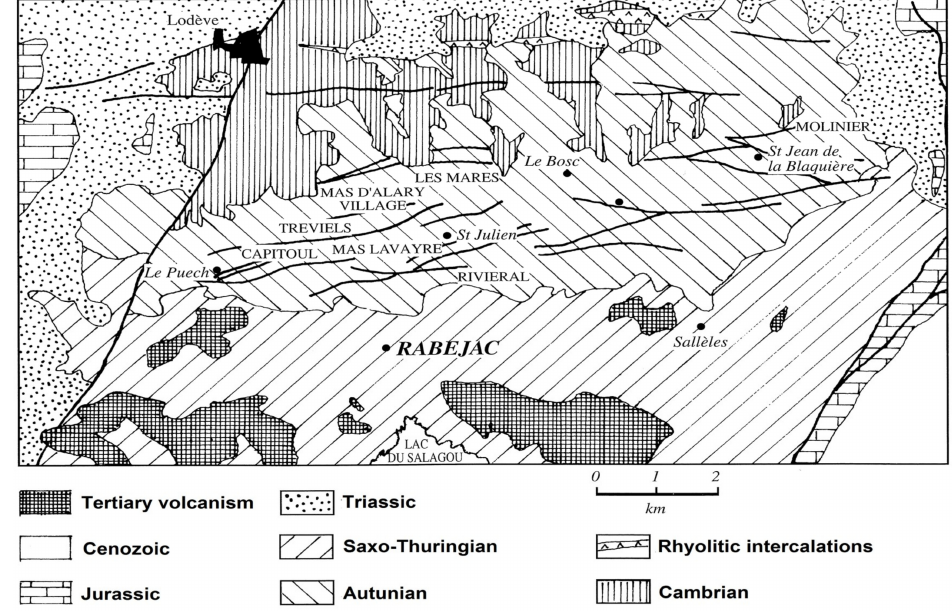
Figure 2. Geological map of the Permian Lod è ve basin, showing the geographical localization of the uranium mines (modified from Caubel, 1997